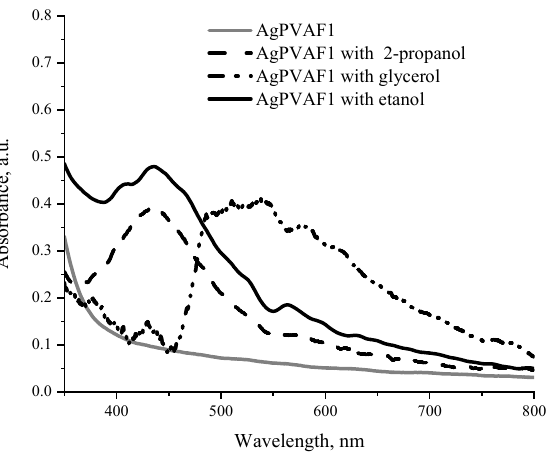
Figure 7. Morphology of PVA, AgPVAF1, and AgGlyPVAF1 films. UV-VIS absorption spectra of the AgPVAF1 films containing different additives and irradiated with a 0.1 Gy dose are shown in Figure 8.